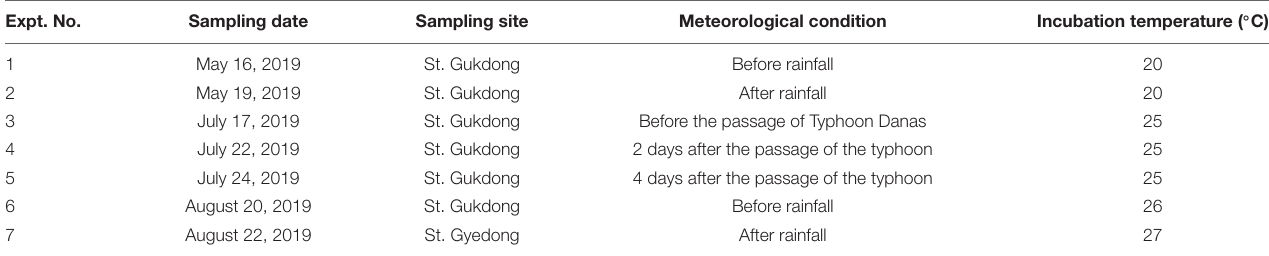
FIGURE 1 | (A) Locations of the study areas in the South Sea of Korea. (B) Stations for seawater sample collection in Gamak Bay (St. Gukdong) and Yeosuhae Bay (St. Gyedong) and the station for automated seawater quality monitoring data acquisition in Gwangyang Bay (St. Gwangyang). (C) Station for the automated seawater quality monitoring data acquisition in Masan Bay (St. Masan). The dotted line in panel (A) indicates the path of the Danas typhoon on July 20, 2019. TABLE 1 | Meteorological conditions when the seawater samples were collected from Station Gukdong and Station Gyedong in 2019 and their incubation conditions. Expt.